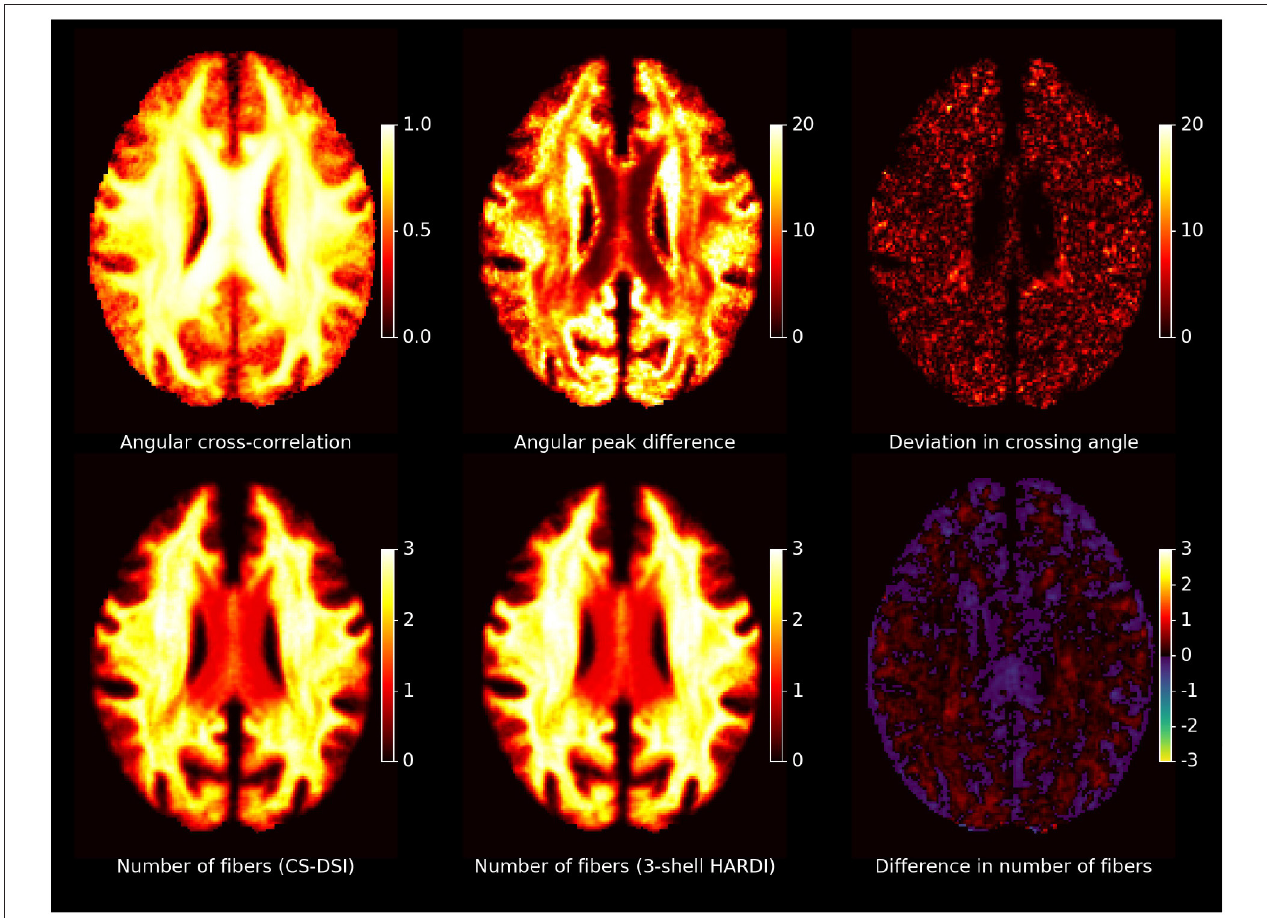
FIGURE 10 | Spatial maps of the orientational information obtained from CS-DSI and 3-shell HARDI acquisitions: An axial slice of group-averaged whole brain maps of the angular cross correlation, the angular peak difference, the deviation in crossing angle and the number of fibers per imaging scheme and the corresponding difference (3-shell HARDI − CS-DSI) is shown. All metrics are computed for fODFs estimated with SHORE order 4, except for the angular cross correlation (SHORE order 8). The angular peak difference and the deviation in crossing angle are reported in